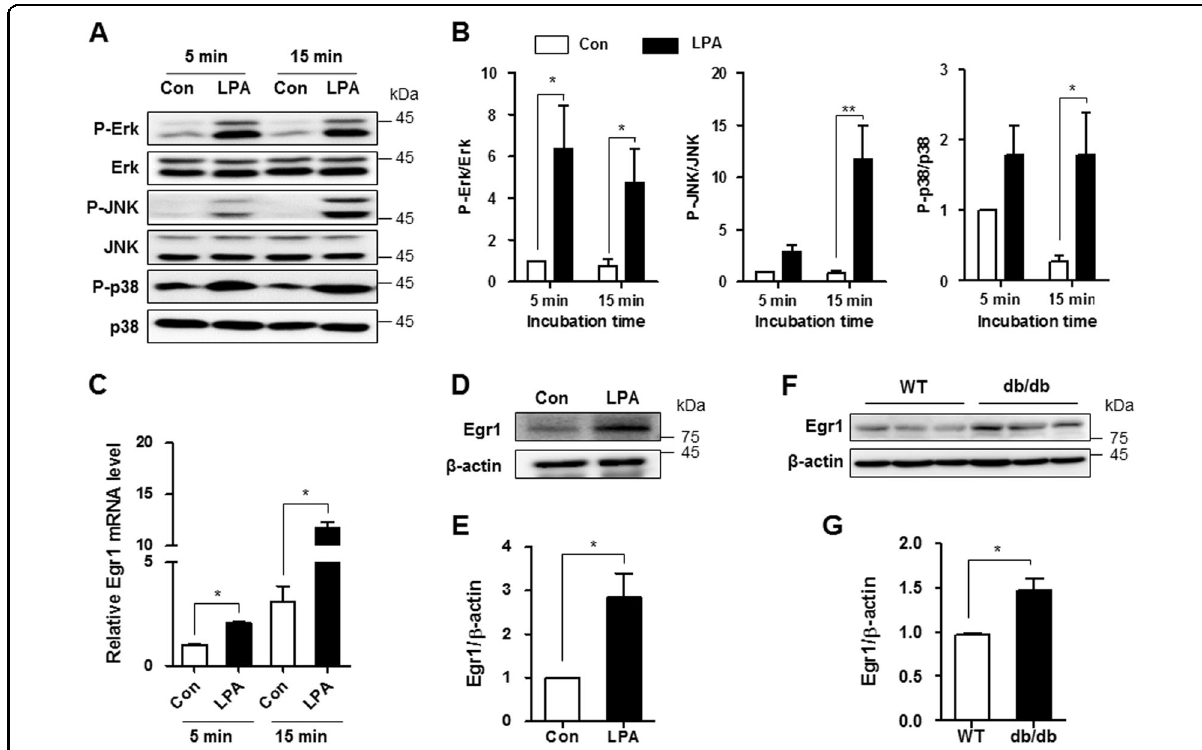
Fig. 5 LPA increases MAPK activation and Egr1 expression in SV40 MES13 cells. a Western blots showing levels of MAPK proteins (p-Erk, total Erk, p-JNK, total JNK, p-p38, and total p38) in cells treated with 10 μ M LPA for 5 or 15 min. b The relative protein levels were normalized to β -actin and quanti fi ed using ImageJ software ( n = 3 independent experiments). c The expression of the Egr1 mRNA was analyzed using qRT-PCR in cells treated with 10 μ M LPA for 5 or 15 min ( n = 3 independent experiments). d Western blots showing the levels of the Egr1 and β -actin proteins in cells treated with 10 μ M LPA for 6 h. e The relative Egr1 levels were normalized to β -actin and quanti fi ed using ImageJ software ( n = 3 independent experiments). f Western blot showing the levels of the Egr1 protein in the renal cortex of 9-week-old wild-type (WT) and db/db mice. g The results were quanti fi ed, and β -actin was used as a loading control ( n = 3 – 4). * p < 0.05, ** p < 0.01. Data are presented as means ±